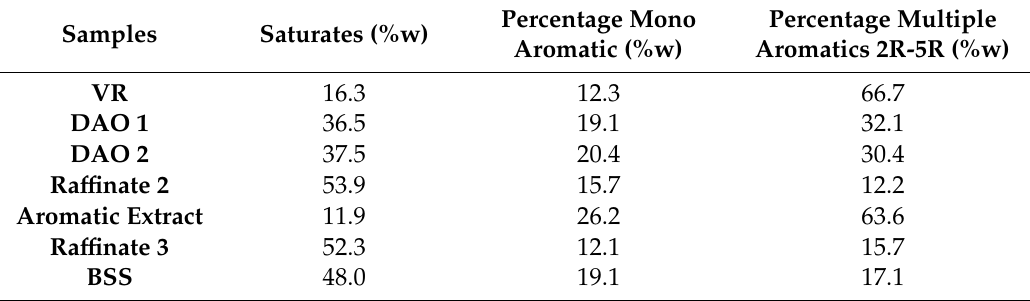
Table 2. Percentage of monoaromatics and multiple aromatics in each